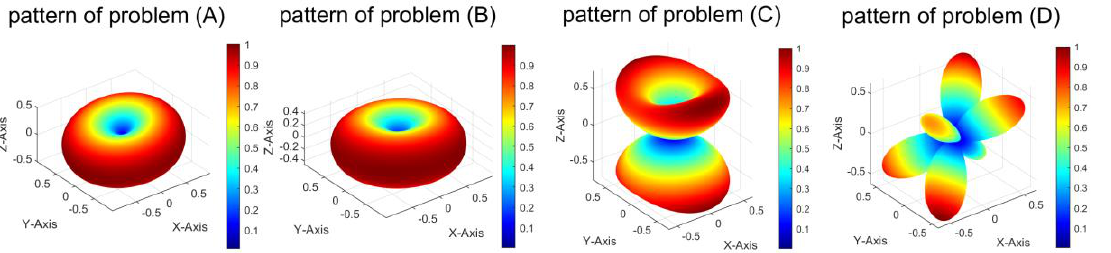
Figure 10. Normalized characteristic patterns of mode 4 for the four different problems at 2.0 GHz.